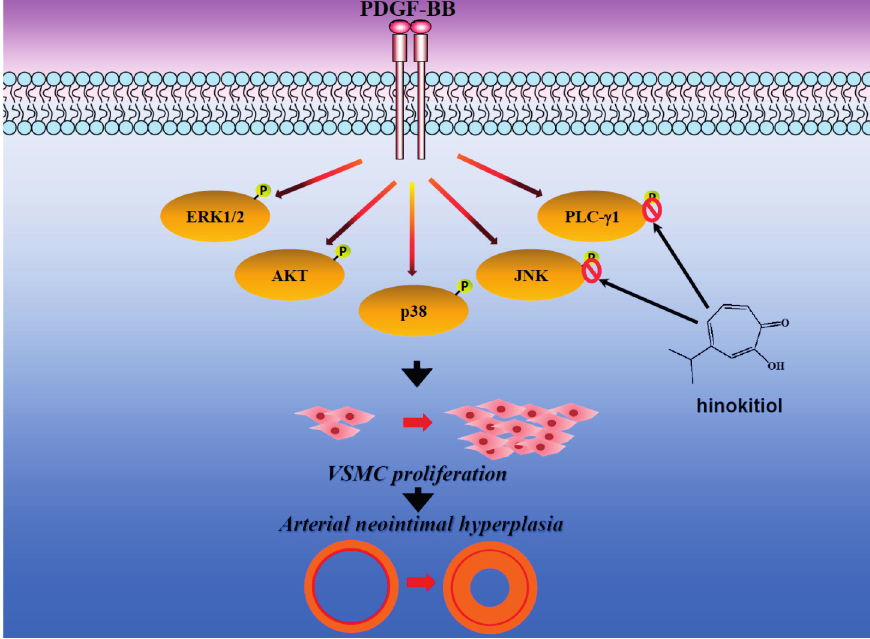
Figure 6. Hypothetical scheme of the inhibitory mechanism of hinokitiol in VSMC proliferation stimulated by